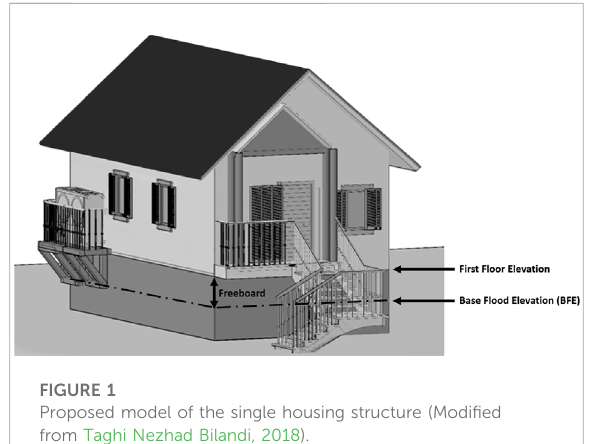
FIGURE 1 Proposed model of the single housing structure (Modi fi ed from Taghi Nezhad Bilandi,